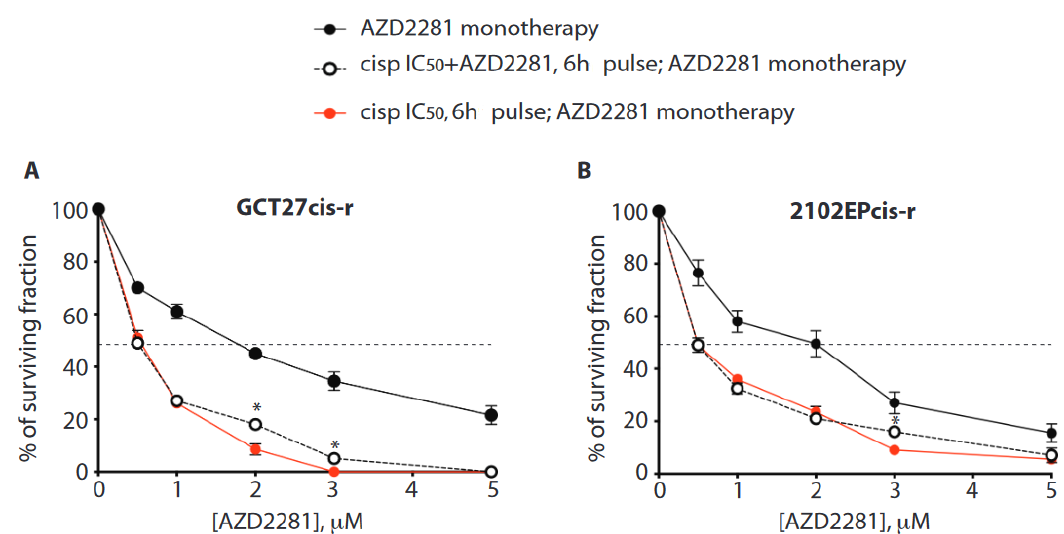
Figure 6. ( A , B ) Colony forming assay of the indicated cell lines treated with cisplatin and poly (ADP-ribose) polymerase inhibitor (PARPi) (AZD2281) combined therapy. AZD2281 monotherapy: Cells were treated with the indicated doses of AZD2281 as a single agent. Cisp IC 50 + AZD2281, 6 h pulse; AZD2281 monotherapy: Cells were treated with the IC 50 dose of cisplatin in combination with the indicated doses of AZD2281 for 6 h. After a washout, cells were incubated with the indicated concentrations of PARPi. Cisp IC 50 , 6 h pulse; AZD2281 monotherapy: Cells were treated with the IC 50 dose of cisplatin for 6 h. After a washout, they were incubated with the indicated increasing concentrations of PARPi as a single agent. Data are mean values ± s.d. of two independent experiments, each performed in triplicate. Combined treatments were both statistically different compared to PARPi monotherapy, at all PARPi amounts tested ( p < 0.05); unpaired one-tailed t -test. Asterisks (*) indicate where a statistically significant difference was found comparing the two cisplatin/AZD2281 co-treatment schedules (unpaired one-tailed t -test, * p < 0.05). The dotted line intercepts the half-maximal inhibitory concentration (IC 50